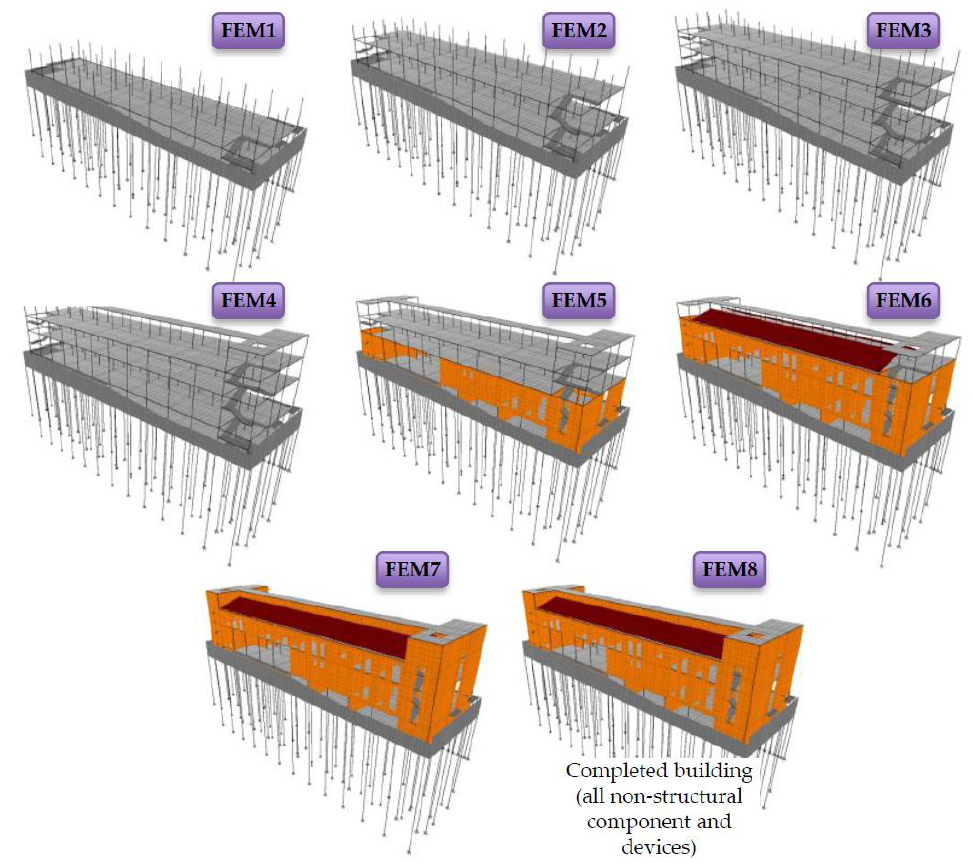
Figure 6. Eight FEMs representing the 8 controlled phases during the building construction.